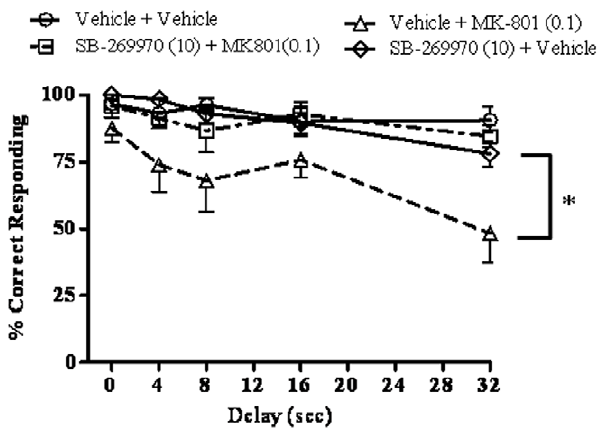
Figure 1. Effects of SB-269970 on MK-801-induced DNMTP deficits. SB-269970 (10 mg/kg) and MK-801 (0.1 mg/kg), or their vehicles, were co-administered 10 min before the beginning of the session (N=6 per group). SB-269970 had no effect on its own but reversed the deficit caused by MK-801 (*p , 0.05, main effect). For statistical details see the result section.